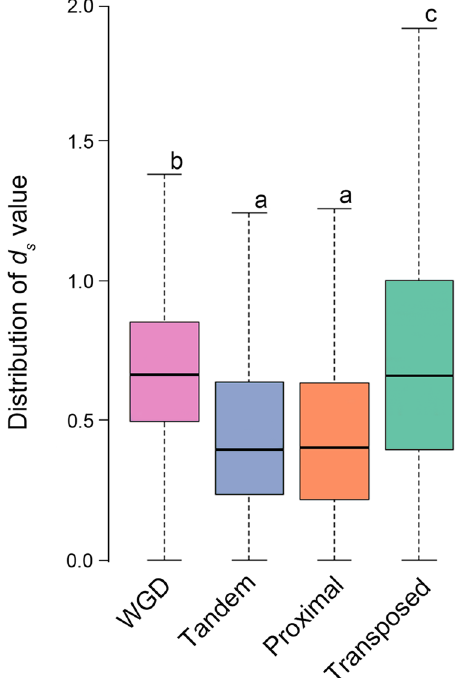
Figure 1. Box-plots showing distribution of the synonymous ( d S ) substitution rates for each of the four different categories of duplicate genes. The y axis shows the distribution of d S values in the four categories of duplicates. The results show significantly different d S distributions in some but not all the pairwise comparisons among the different categories of duplicates, according the Kolmogorov-Smirnov test ( p values < 2e-16). Boxblots with different letters indicate statistically different d S distributions.